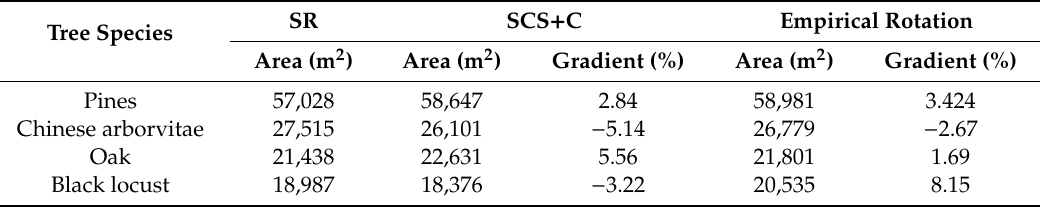
Table 5. Area statistics derived from classification of the tree species. SR represents the data of the precorrected data classification results. The SCS + C model and empirical rotation model represent the data after topographic correction. The gradient represents the change rate between the before and after correction data.